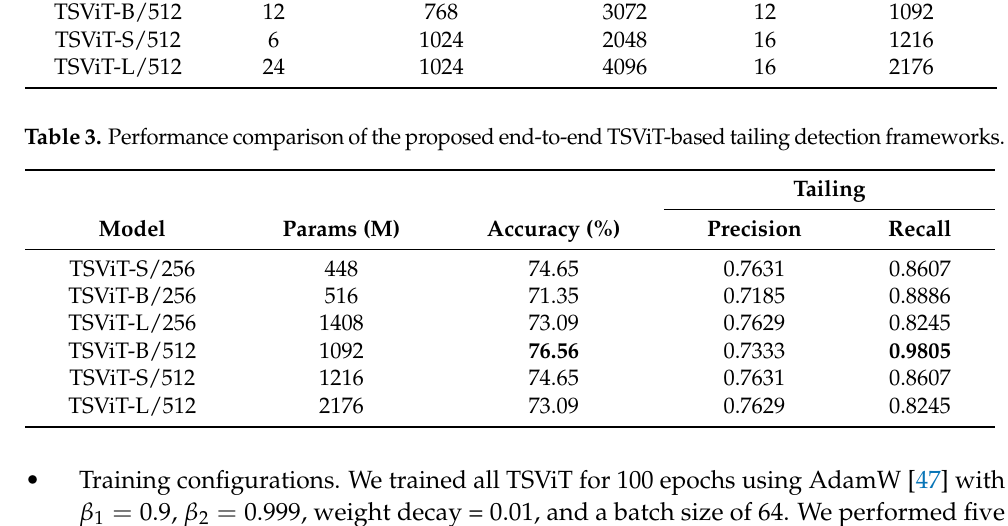
Table 2. Details of the various Vision Transformer architectures used in our experiments. Model